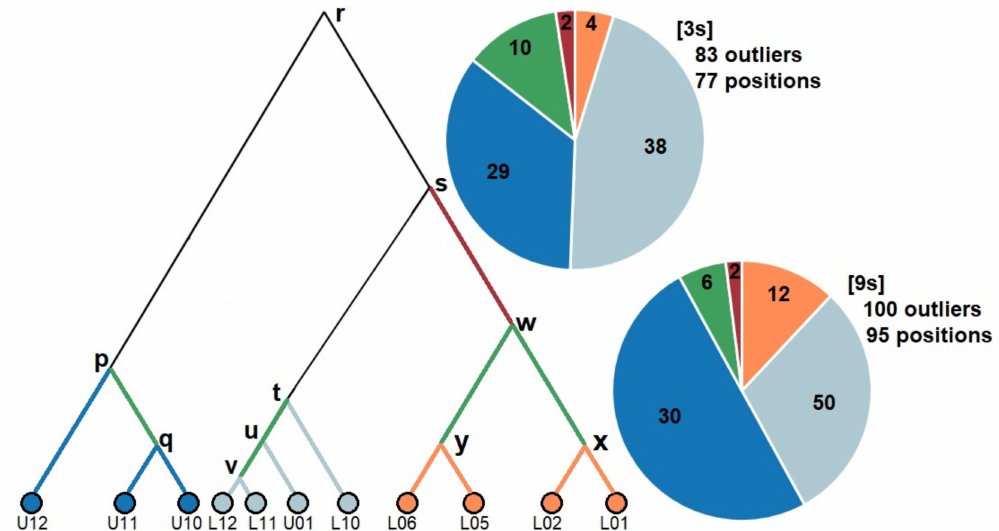
Figure 7. Consensus admixture graph used by GRoSS v1.0 for the detection of outlier SNPs in the two species, along with pie charts visualising the distribution of outlier SNPs across five categories of specific branches of this admixture graph. Orange : lowland brackish water terminal branches. Light blue : lowland freshwater terminal branches. Dark blue : upland freshwater terminal branches. Green : branches within the geographical subgroups. Dark red : branch splitting the freshwater from the brackish water sites. In total, the 10,836 (3s) and 15,033 SNPs (9s) were tested for signatures of selection along 20 branches, resulting in a proportion of 0.0383% (83/[20*10,836]) and 0.0333% (100/[20*15,033]) outliers in three-spined stickleback and nine-spined stickleback, respectively. The distribution of outlier SNPs over the five categories differs significantly between species (Chi-squared test: χ 2 = 10.03, P =